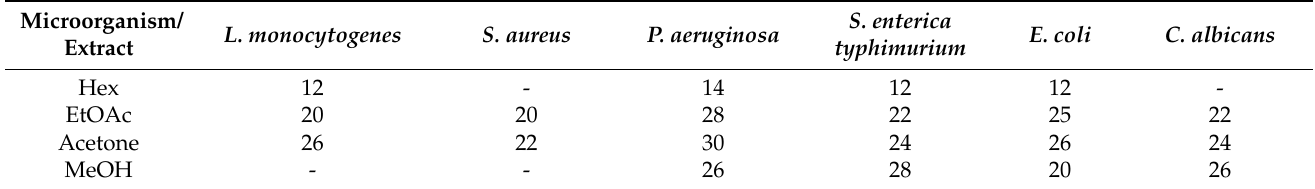
Table 6. Antimicrobial activity of Erodium arborescens aerial part extracts against the six tested indicator microorganisms. The diameters of inhibition zones were reported in millimeter